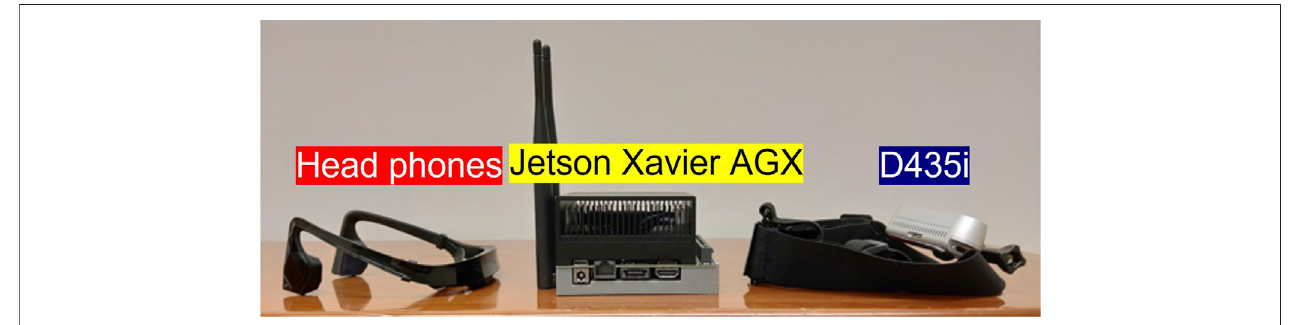
FIGURE 7 | A test participant with the wearable system. The yellow region is a bag carrying a Jetson Computer and battery. The blue region is head-mounted camera, and the red means a bone-conducted